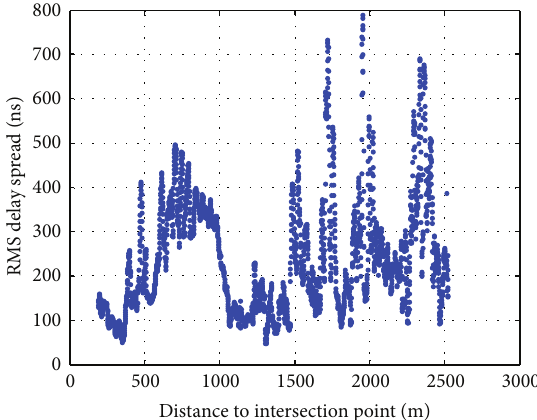
Figure 3: RMS delay spread in HSR hilly terrain.